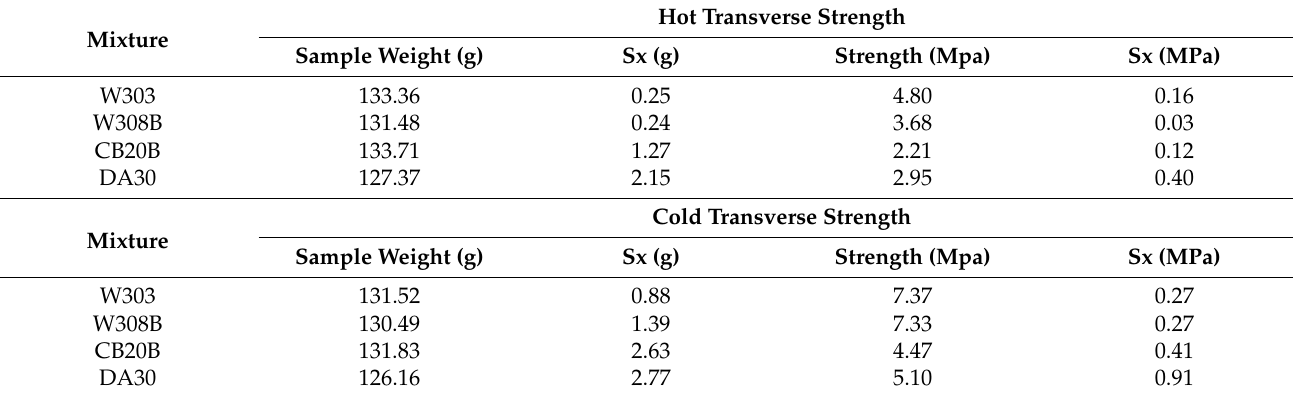
Table 3. Mechanical properties of mixtures with tested